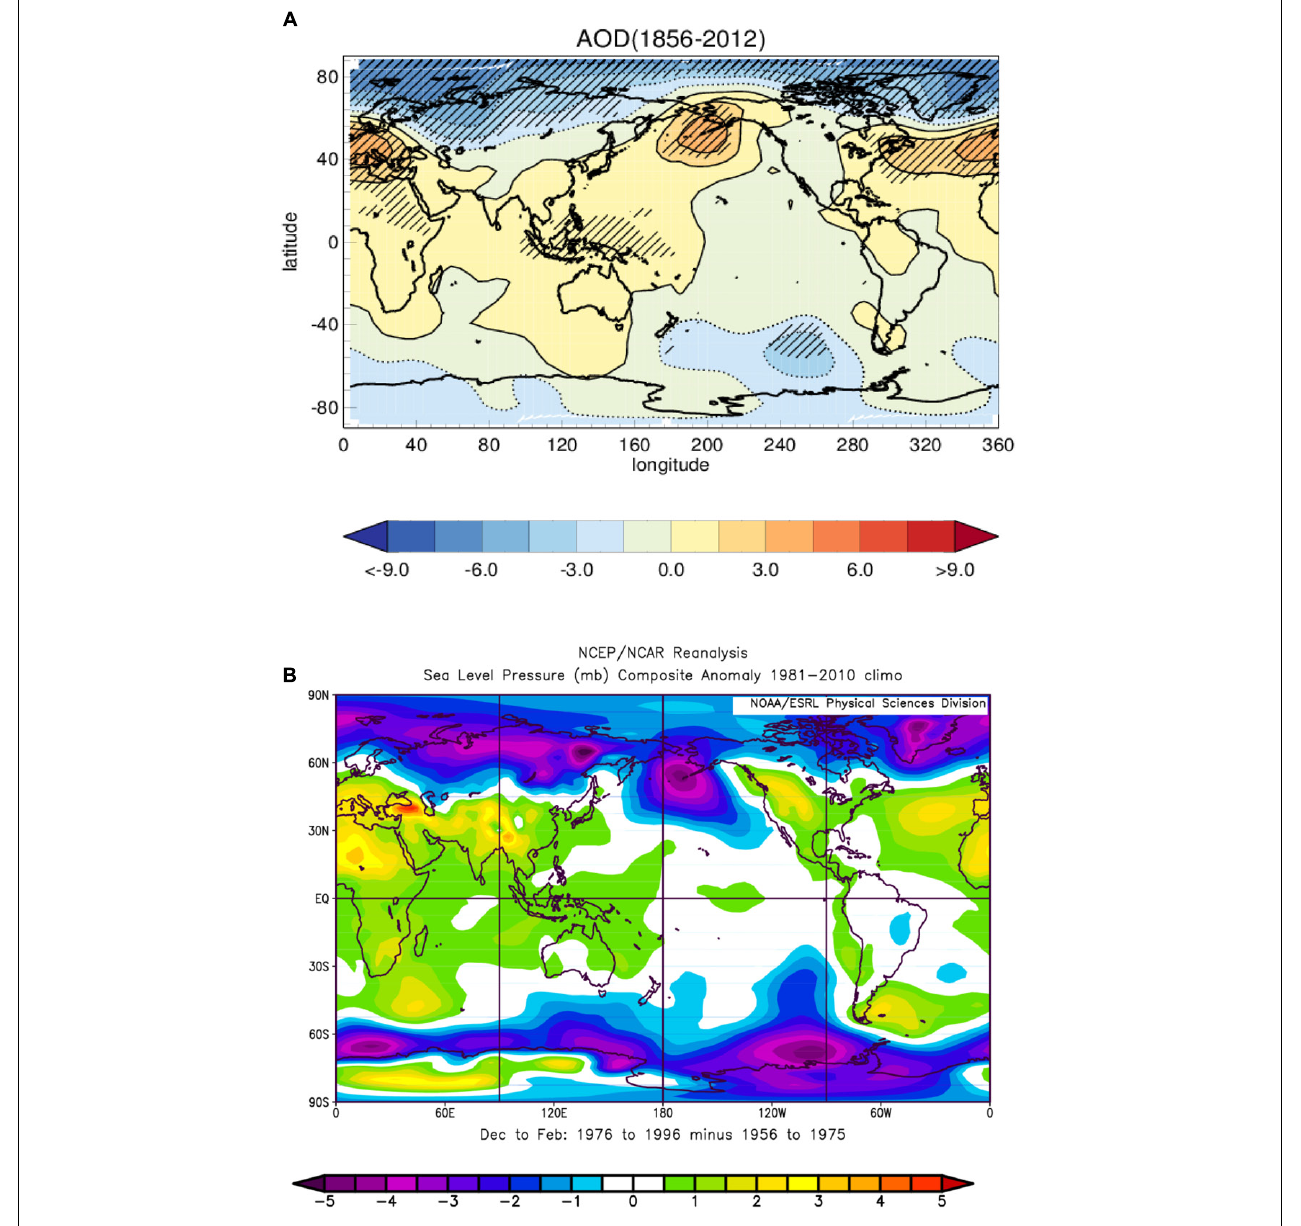
FIGURE 1 | (A) The AOD (for volcano) signal (max–min, hPa) using a MLR technique on SLP (DJF) data for the period 1856–2012. Other indices used are ENSO, SSN and a longer term trend. Significant areas (95% significant) using a two-sided Student’s t -test are marked by hatching and negative contours are shown by dotted lines. (B) The result of SLP anomaly (DJF) plot from NCEP data for 1976–1996 with respect to reference level 1956–1975. Plot (B) is generated from the NOAA/ESRL Physical Sciences Division, Boulder Colorado web site at